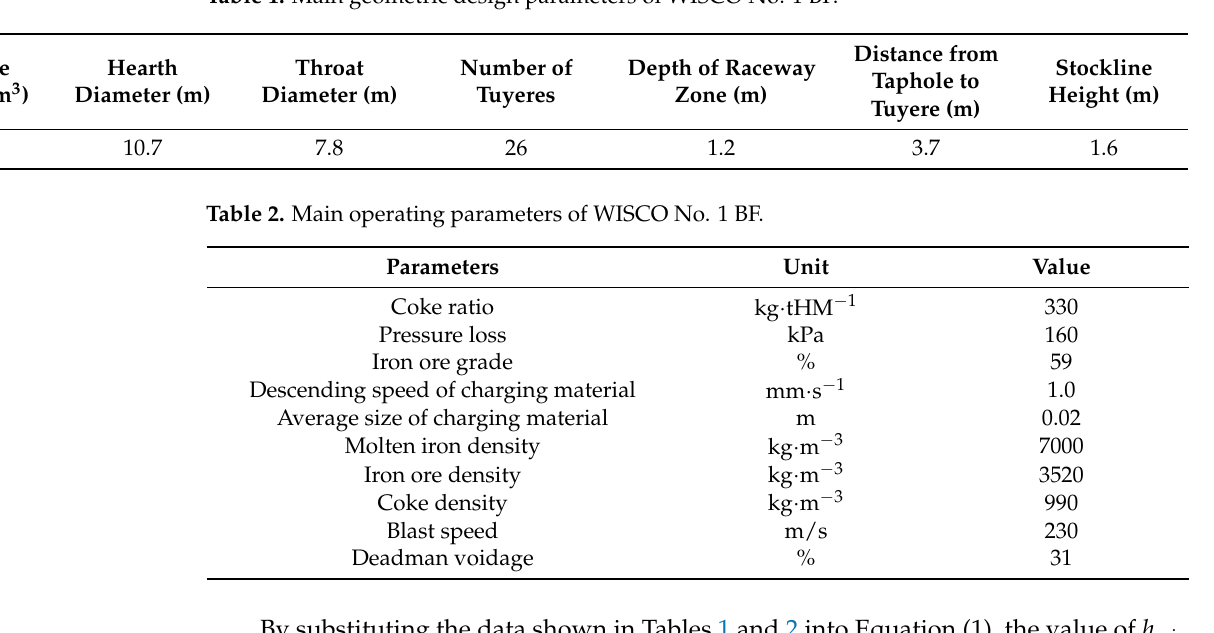
Table 1. Main geometric design parameters of WISCO No. 1 BF.